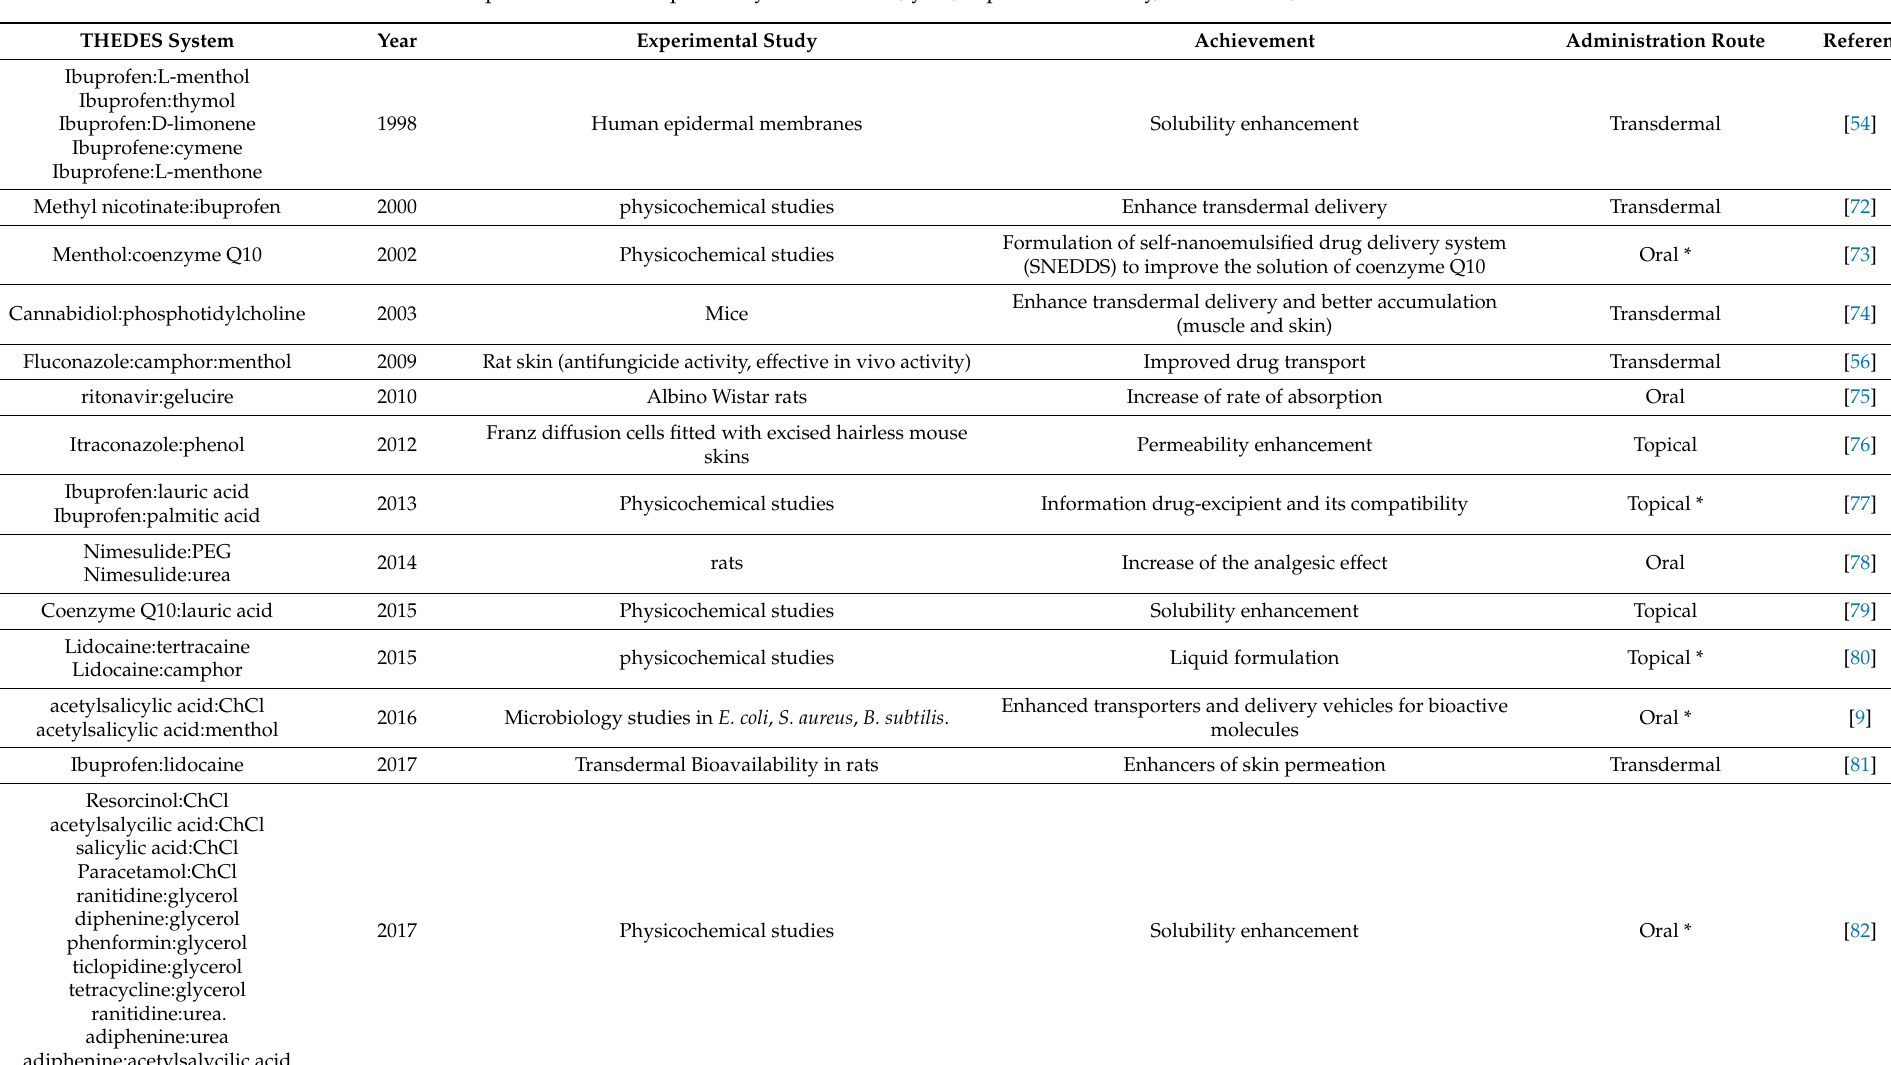
Table 2. Examples of API-DES reported by the literature, year, experimental study, achievement, and administration